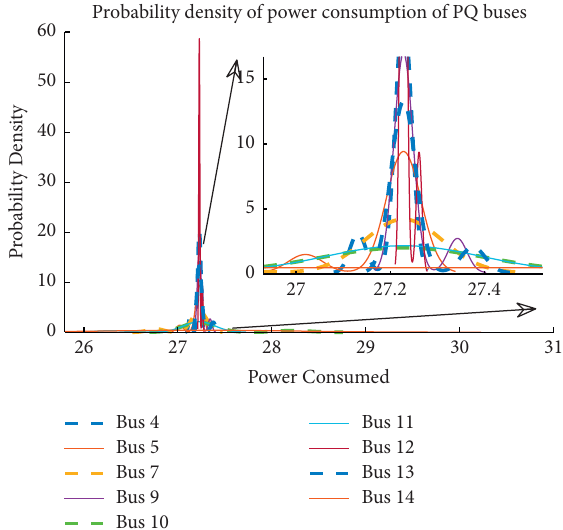
Figure 19: Cumulative power distribution at buses 4, 5, 7, and